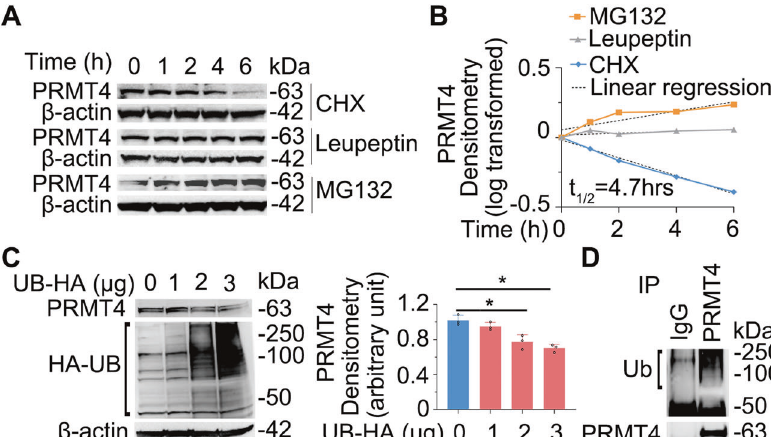
Fig. 2 PRMT4 is a labile protein degraded via the ubiquitin proteasomal machinery. A BEAS-2B cells were treated with cycloheximide (CHX), leupeptin, or MG132 as indicated. Cell lysates were immunoblotted with PRMT4 and β -actin antibodies. B Densitometry results in A were analyzed in semi-log format with GraphPad prism 5 and the results were plotted. C Ectopic expression of ubiquitin reduces PRMT4 protein in a concentration-dependent manner. Densitometry was plotted in the right panel. D PRMT4 is polyubiquitinated as shown by co- immunoprecipitation (Co-IP) of precipitates analyzed with ubiquitin and PRMT4